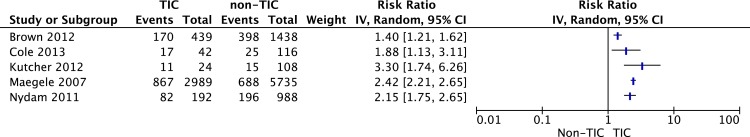
The impact of TIC on the development of MOF. Studies have reported an association between TIC and the incidence of MOF; however, pooling of data was not possible due to substantial heterogeneity.